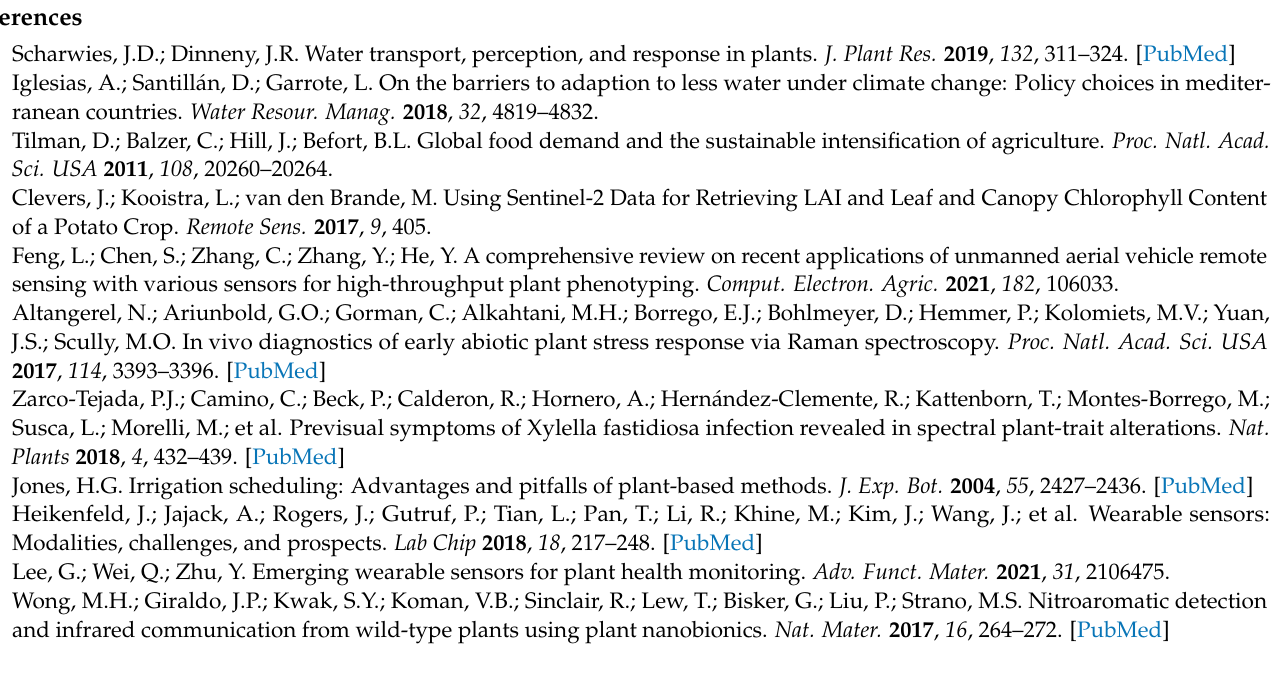
GO. Figure S3: Hysteresis characteristic of the GO based sensor at 100 Hz; Figure S4: The fifteen-cycle response-recovery curve of GO based sensor. Figure S5: The long-term stability of the sensor. Figure S6: Calibration curve of maize plant leaf transpiration sensing; Figure S7: Schematic diagram of application scenario of the GO based flexible sensor for in situ real-time tracking of plant